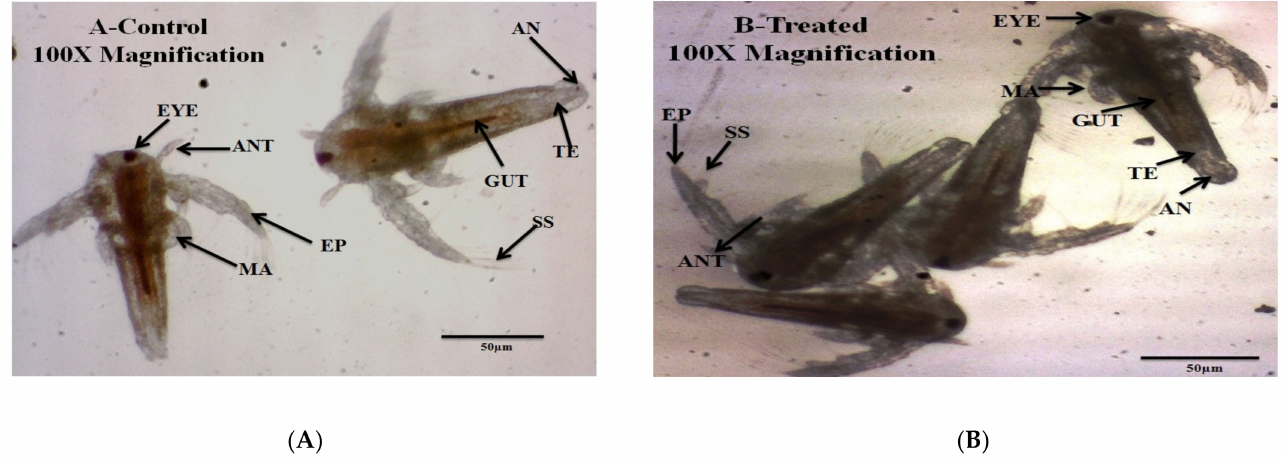
Figure 2. Morphological changes of A. nauplii exposed of M. anisopliae secondary metabolites at post 24 h of treatment. ( A ). Control (not treated fungal extract), ( B ). M. anisopliae secondary metabolites treated